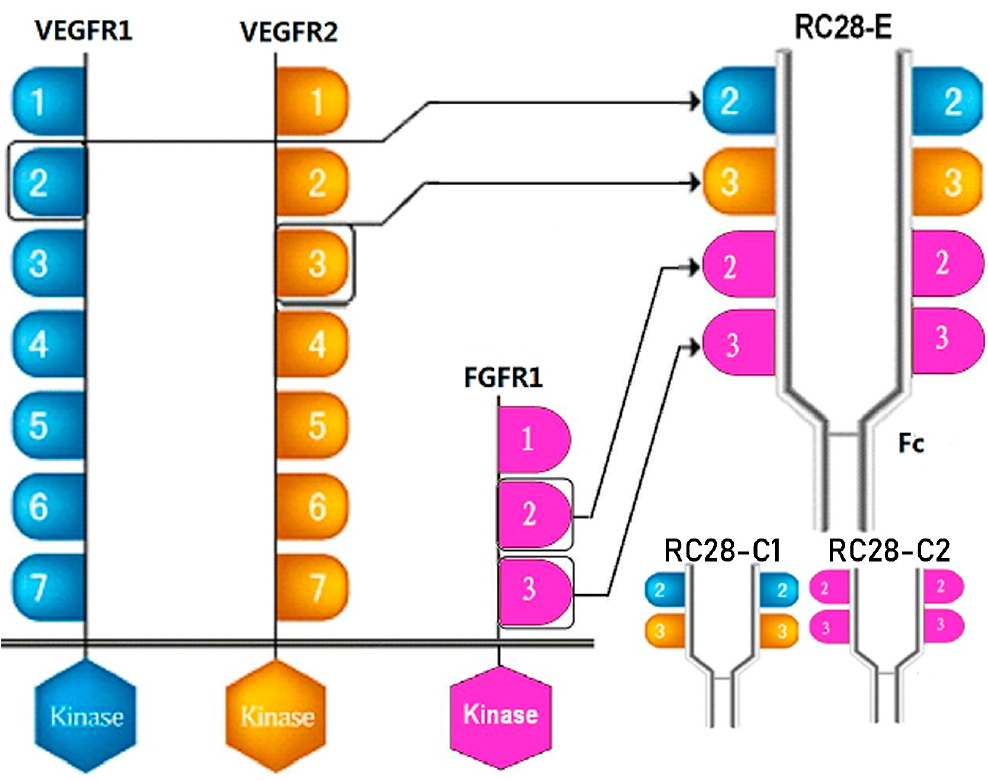
Figure 1. Schematic diagram of RC28 molecular design. VEGFR1: vascular endothelial growth factor receptor 1; FGFR1: fibroblast growth factor receptor 1.